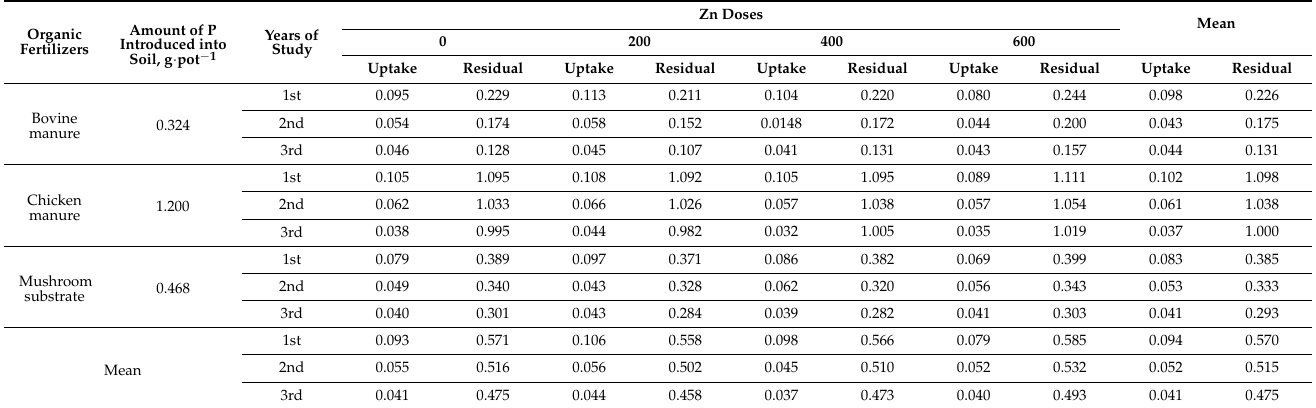
Table 8. Phosphorus balance introduced into soil with organic fertilizers in three years under different zinc doses (P remained in the soil in